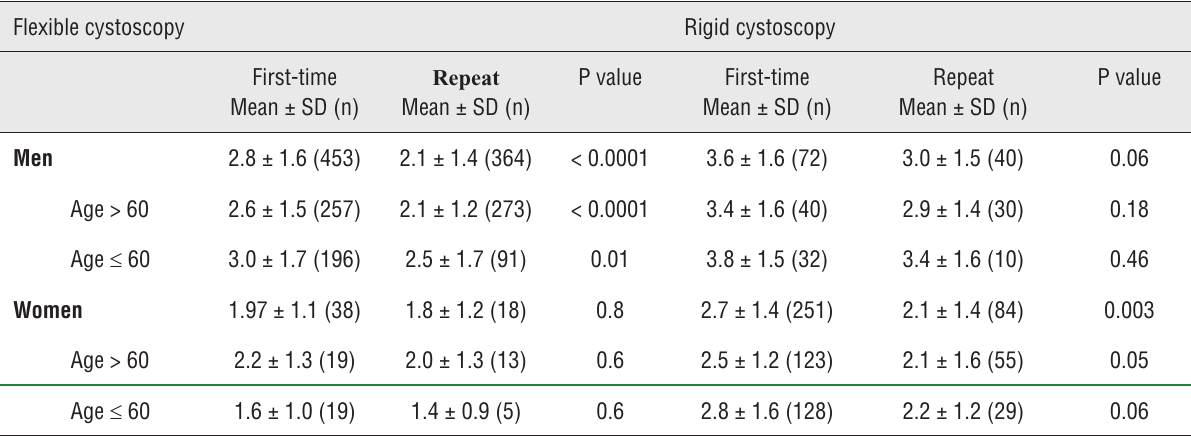
Table 1 - Visual analog scale pain levels stratified by age. Flexible